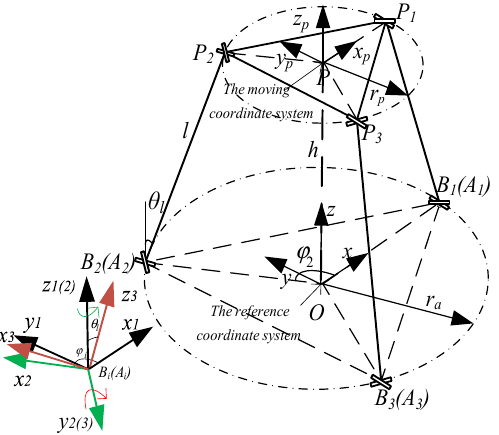
Figure 3. The coordinate system diagram of simplified PRB model.